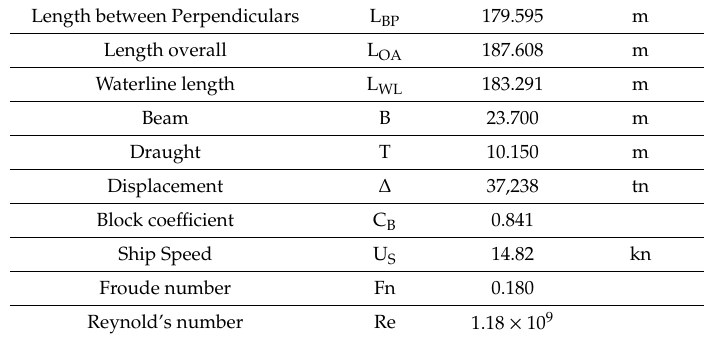
Figure 2. The hull shape. Table 2. Characteristics of the ship.